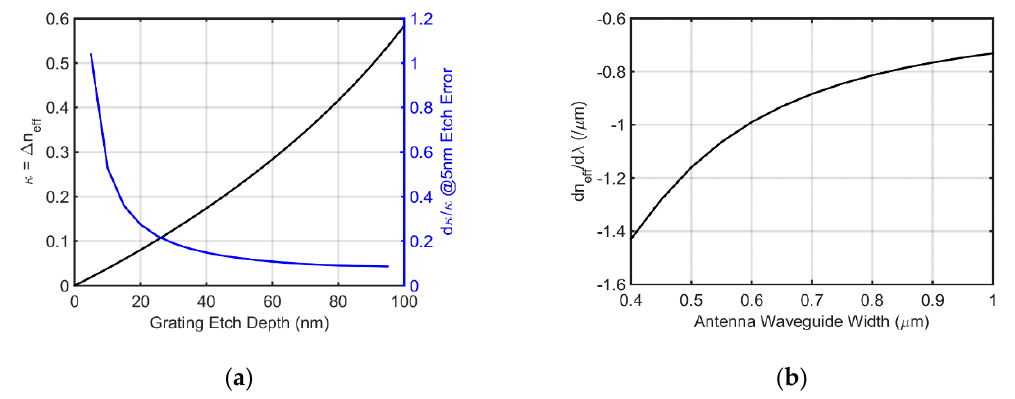
Figure 5. ( a ) The effective refractive index change and its relative error at 5 nm etch error as a function of grating etch depth for a 500 × 220 nm 2 Si waveguide. ( b ) The effective index change rate with respect to wavelength as a function of waveguide width for a 220 nm thick waveguide antenna.